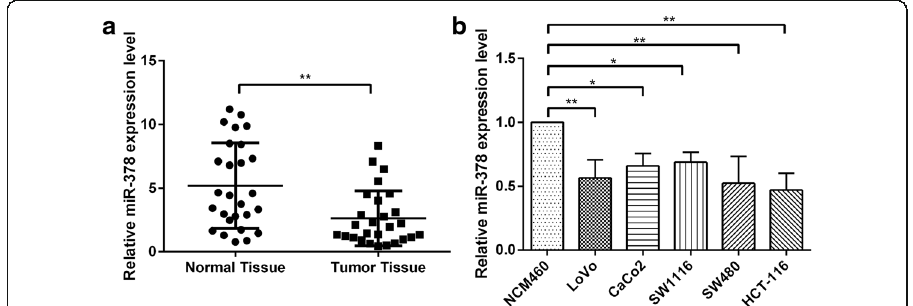
Fig. 1 miR-378 is downregulated in CRC samples and cell lines. a Expression of miR-378 in 27 CRC samples was compared with that in adjacent non-tumor tissues; determination via quantitative RT-PCR. U6 snRNA served as an internal control. b Quantitative RT-PCR was performed to detect the expression of miR-378 in 5 CRC cell lines (LoVo, CaCo2, SW1116, SW480, HCT-116) and a normal colonic cell line (NCM460). * p < 0.05, ** p <